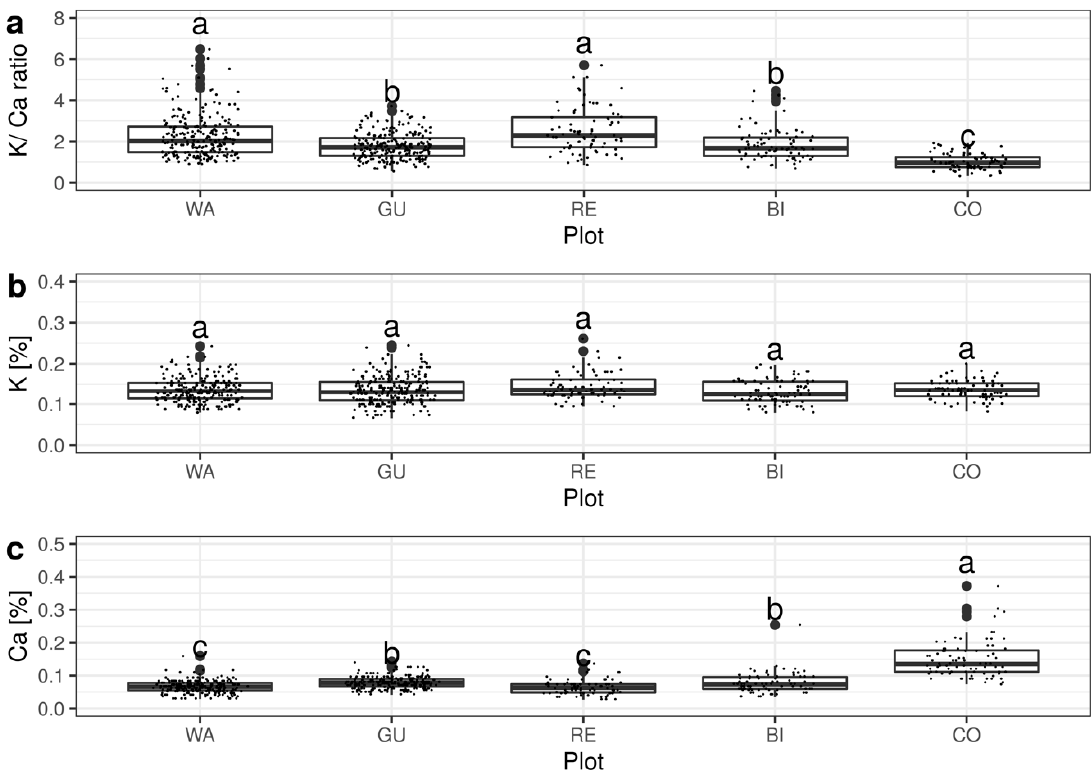
Figure 5. Potassium and calcium ratios in fruits measured using X-ray fluorescence (XRF). Mean K / Ca ratio ( a ), potassium ( b ), and calcium ( c ) concentrations measured using XRF for the trial 2018 to 2019. Letters denote significant di ff erences after Kruskal–Wallis rank sum test and Dunn post-hoc analysis showing significant di ff erences in calcium concentrations, and thus K / Ca ratios by orchard, while potassium values do not di ff er significantly.